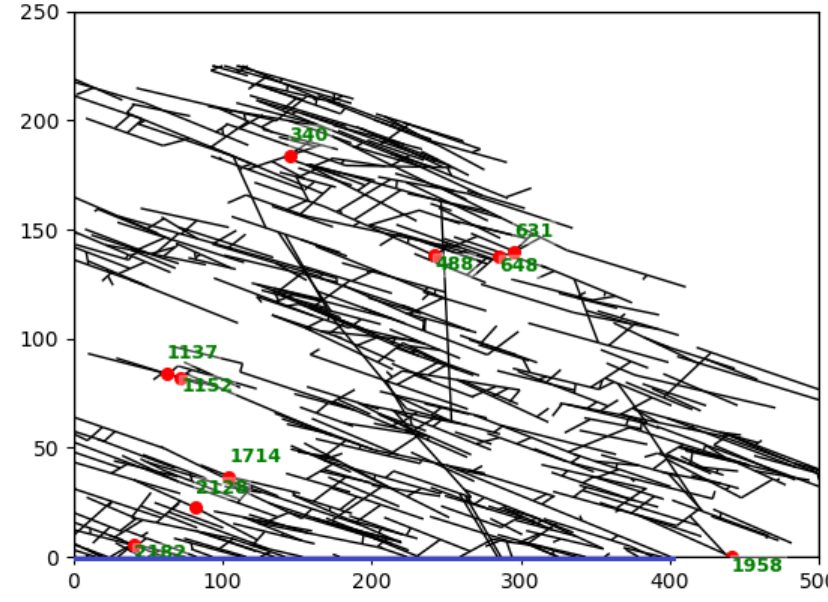
Figure 14—log-log plots of MSD vs. time for 10 sampled nodes in Case 3. Case 4.